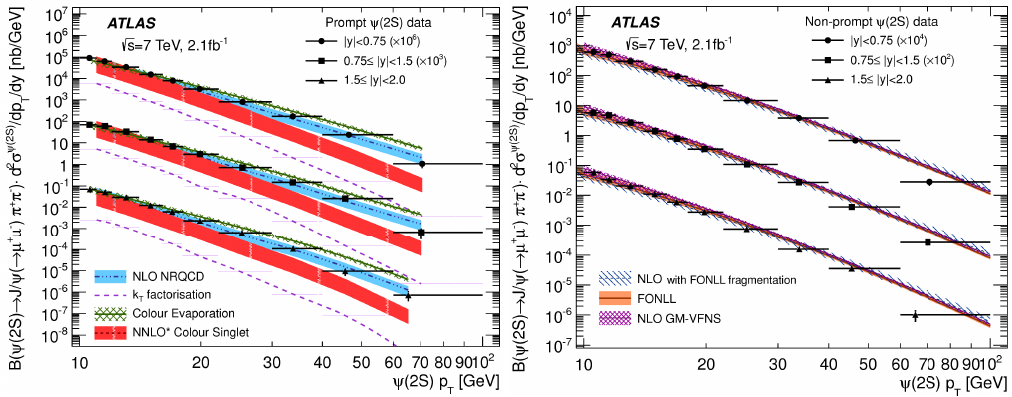
Figure 5: Di ff erential cross-sections for prompt ψ (2 S ) (left) and non-prompt ψ (2 S ) (right)